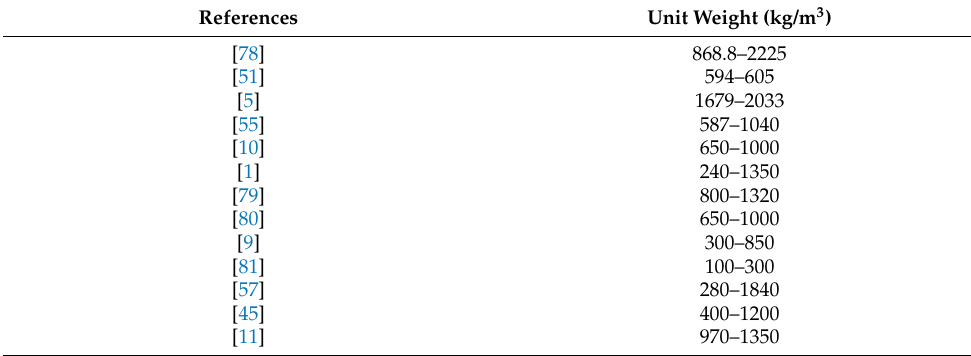
Table 6. Unit weight of foam concretes in the